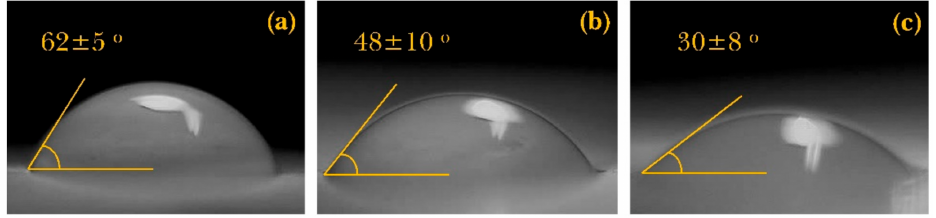
Figure 4. Water contact angle images (mean ± standard deviation) of ( a ) PCL/Gel, ( b ) PCL/Gel + 1% EPS, and ( c ) PCL/Gel + 2% EPS nanofiber